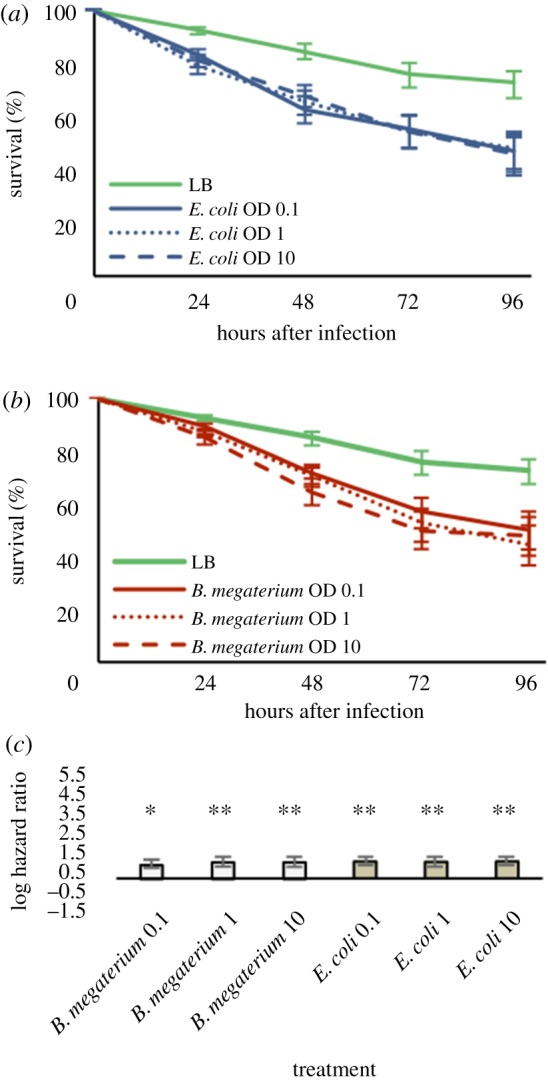
Sancassania berlesei can resist bacterial infection. (a,b) S. berlesei adult females were infected with E. coli (a) or B. megaterium (b) at three concentrations or with LB as control and their survival was followed daily over 4 days. Bacterial infection decreased survival but to a lesser degree than that observed in T. urticae. In (a,b), vertical bars correspond to the standard errors of survival estimates, obtained from the Cox proportional hazards models. (c) Hazard ratios of S. berlesei adults injected with bacteria relative to LB-injected controls. Vertical bars correspond to the 95% CIs of the estimated hazard ratios. *p < 0.05; **p < 0.01 and ***p < 0.001.